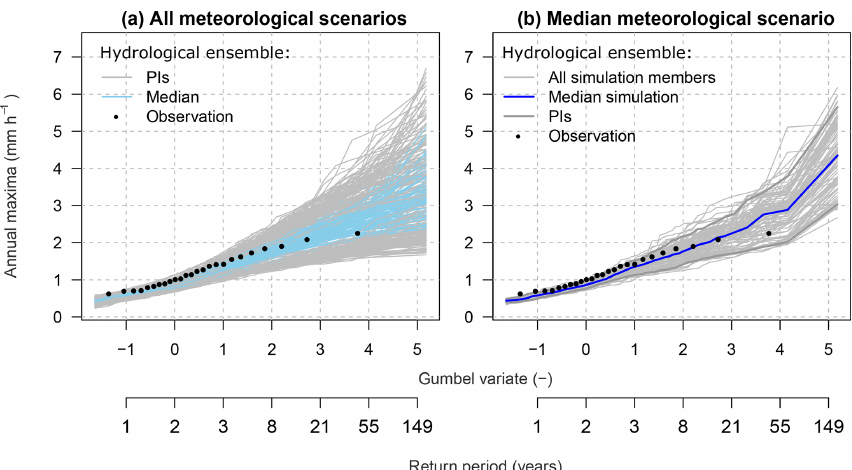
Figure D2. Variability in 100 hydrological scenarios used in this study; (a) hydrological ensemble with all meteorological scenarios and all hydrological-model parameters; (b) hydrological ensemble with all hydrological-model parameters but for the median meteorological scenario only. PIs represent the 90% predictive